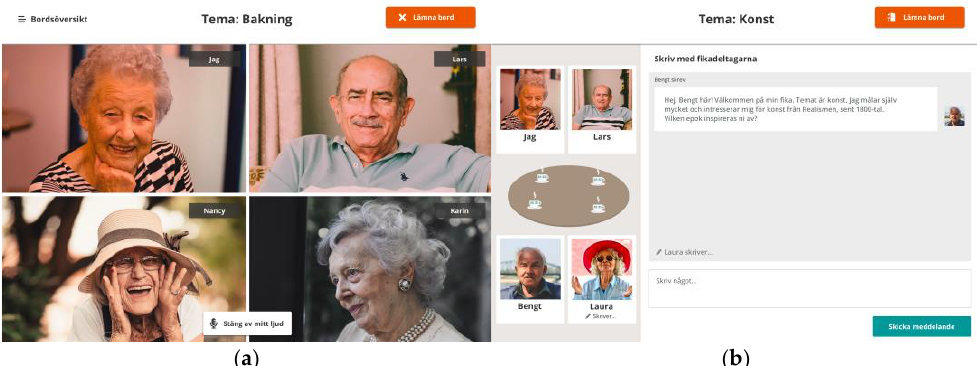
Figure 1. Print screen ( a ): A video conversation on the theme of baking (bakning in Swedish). Print screen ( b ): A chat conversation on the theme of art (konst in Swedish).